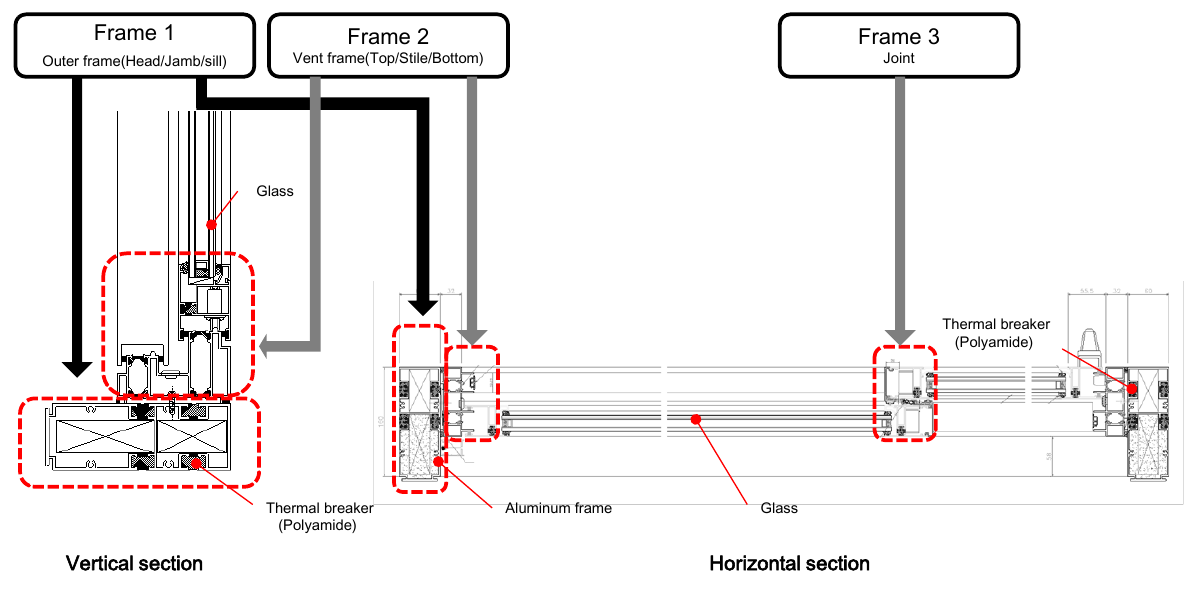
Figure 3. Composition of a SW.